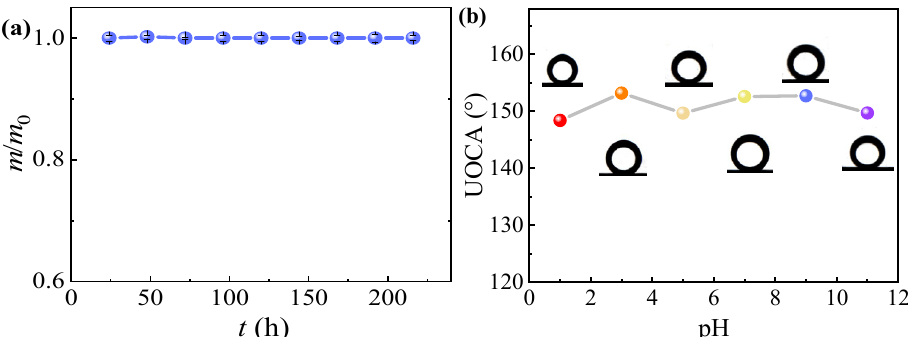
Figure 4. ( a ) Weight loss of NCM after immersion in water for different time, ( b ) underwater oil contact angel (UOCA) at different pH value.